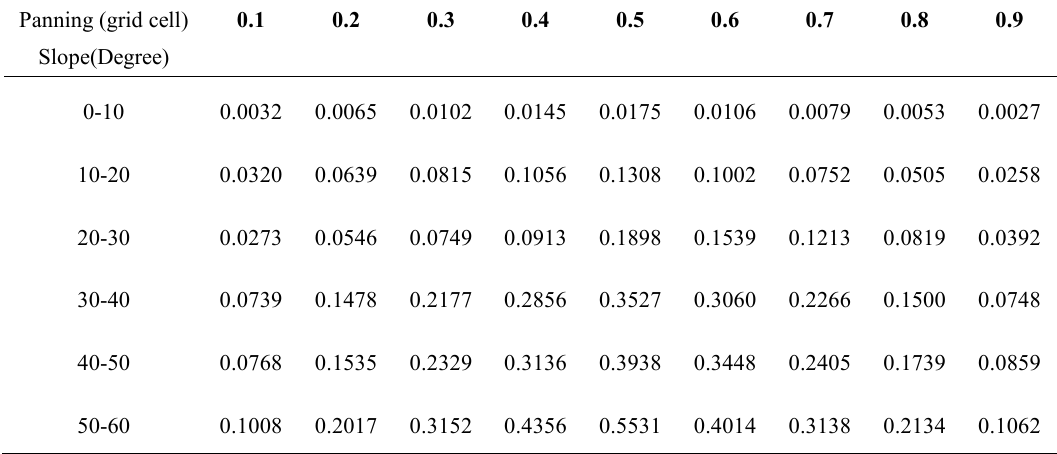
Table 2. Statistical results in different slope and panning quantity.